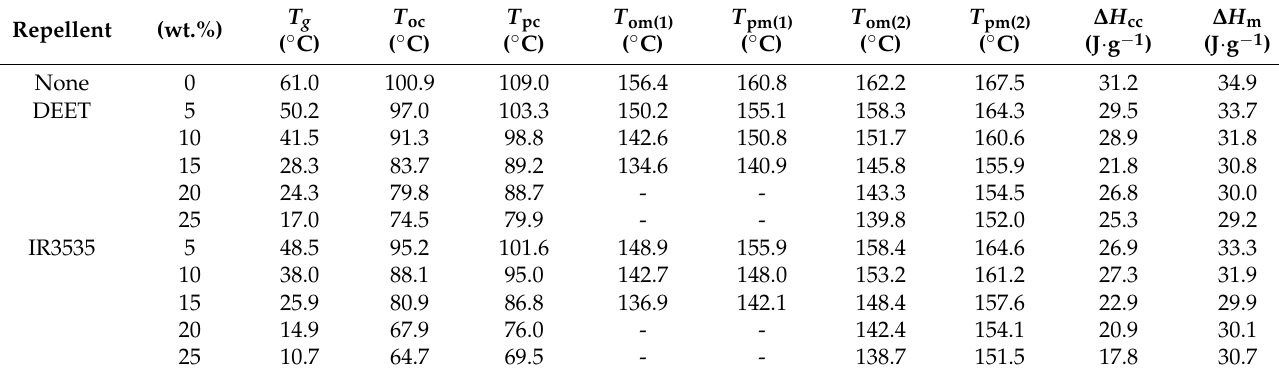
Table 1. DSC Parameters obtained for neat PLA, PLA/DEET and PLA/IR3535 blends. Repellent